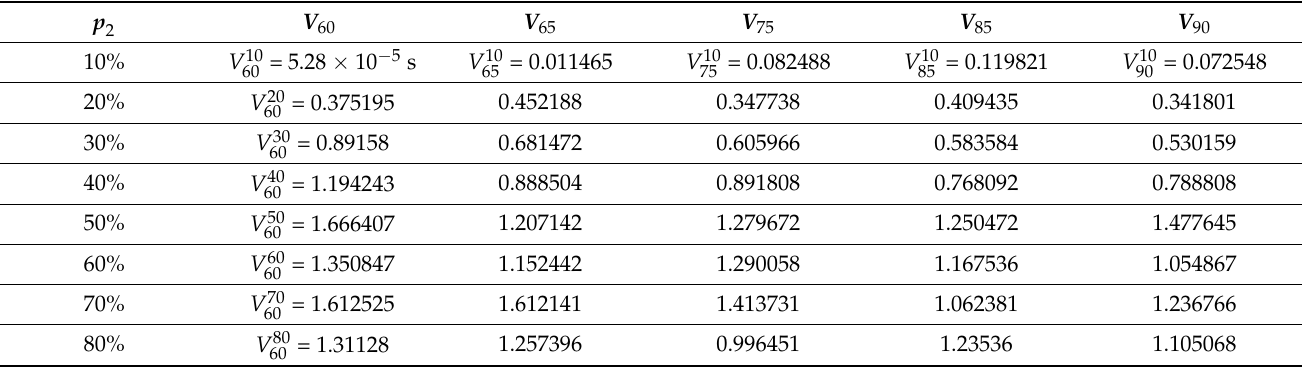
Table 3. Extra travel time variability